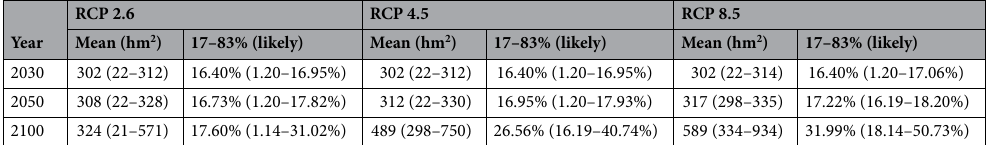
Table 2. Area (hm 2 ) and percentage of future mangrove loss in Dongzhaigang under different climate scenarios (RCPs 2.6, 4.5, and 8.5) (likely ranges).